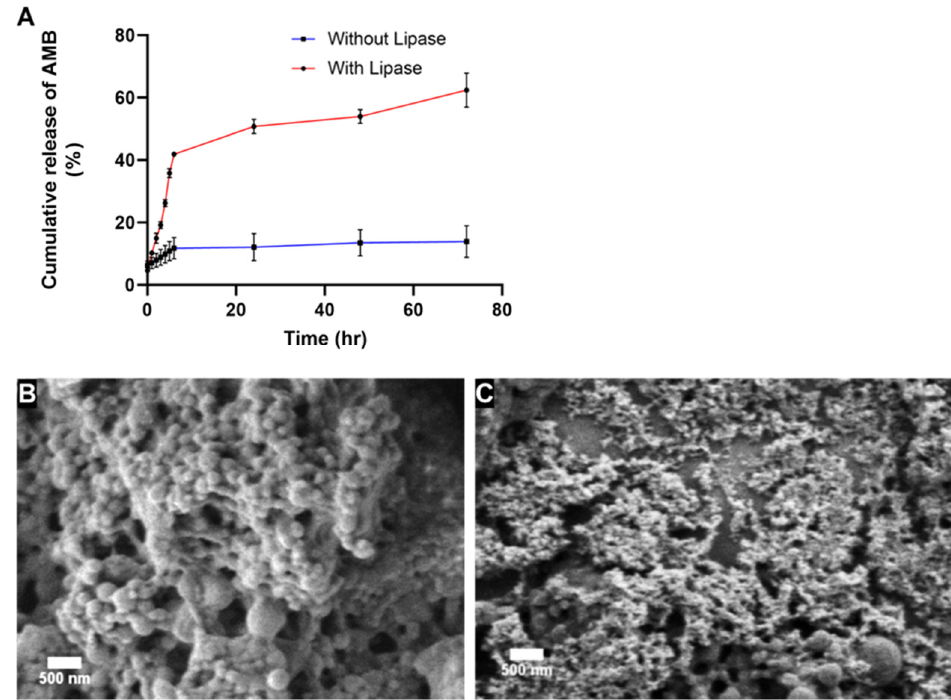
Figure 4. Cumulative release of AMB from PCL-AMB NPs in the presence and absence of lipase ( A ). Surface morphologies of PCL-AMB NPs after 72 h release in the absence of lipase ( B ) and the presence of lipase ( C ). The scale bar represents 500 nm.